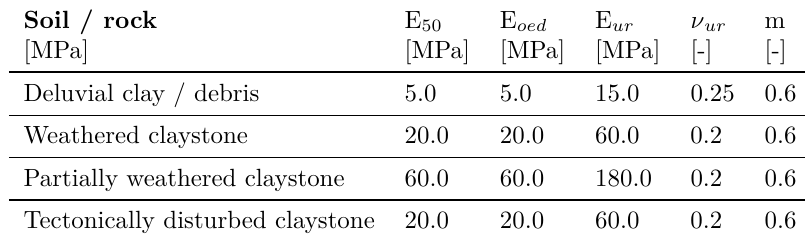
Table 2. Soil/rock parameters used in FEM calculations.